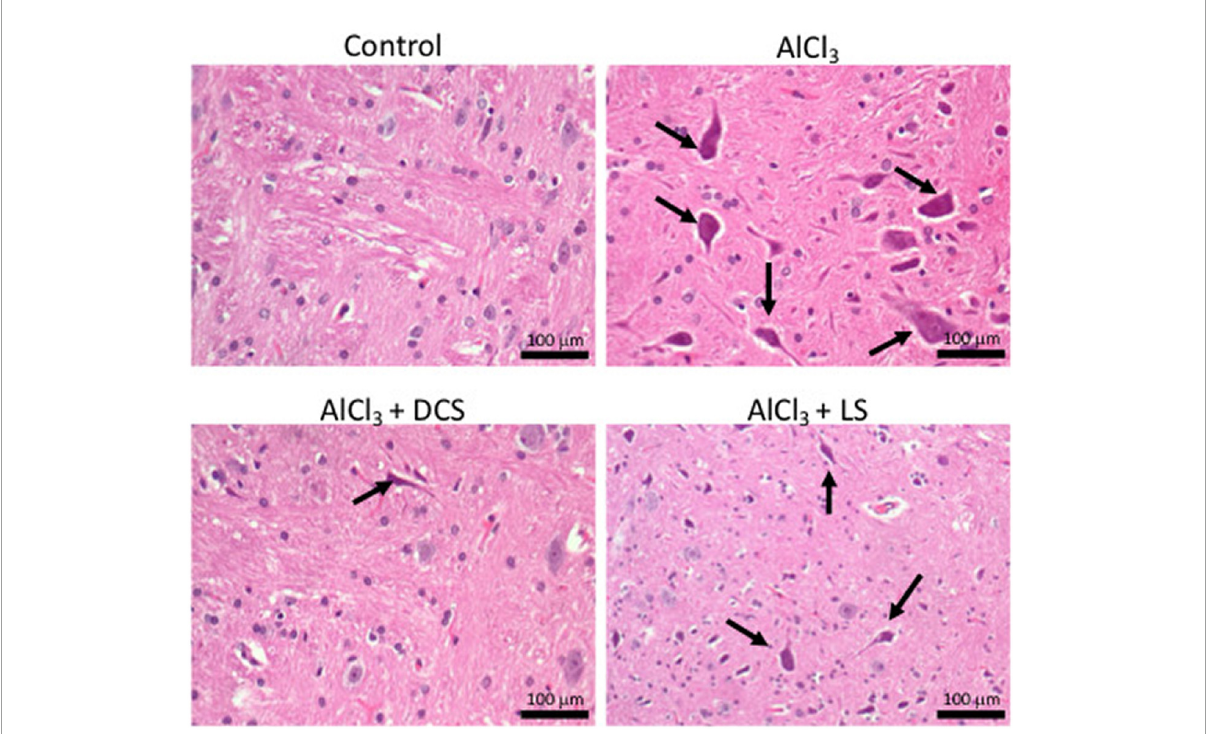
FIGURE4 Representative histopathology images in the rat brain ( n = 3) (hematoxylin-eosin, original magnification 200 × ) Arrows indicate neurofibrillary